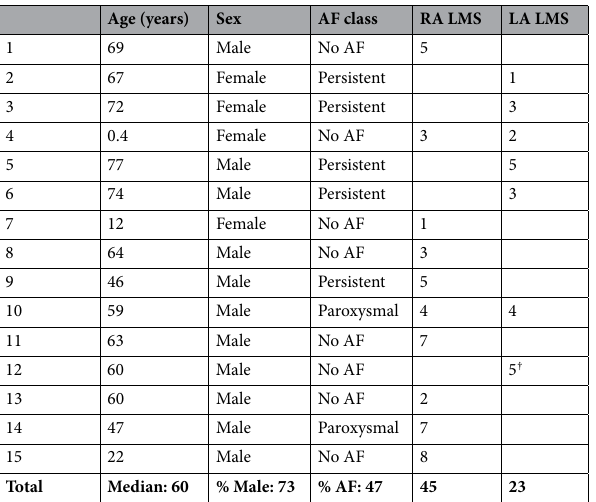
Table 1. Baseline characteristics of patients who donated biopsies for LMS production. Patients were classified in AF classes based on information from their medical records. AF atrial fibrillation, LA left atrium, LMS living myocardial slices. RA right atrium. † Pulmonary vein antral slices.